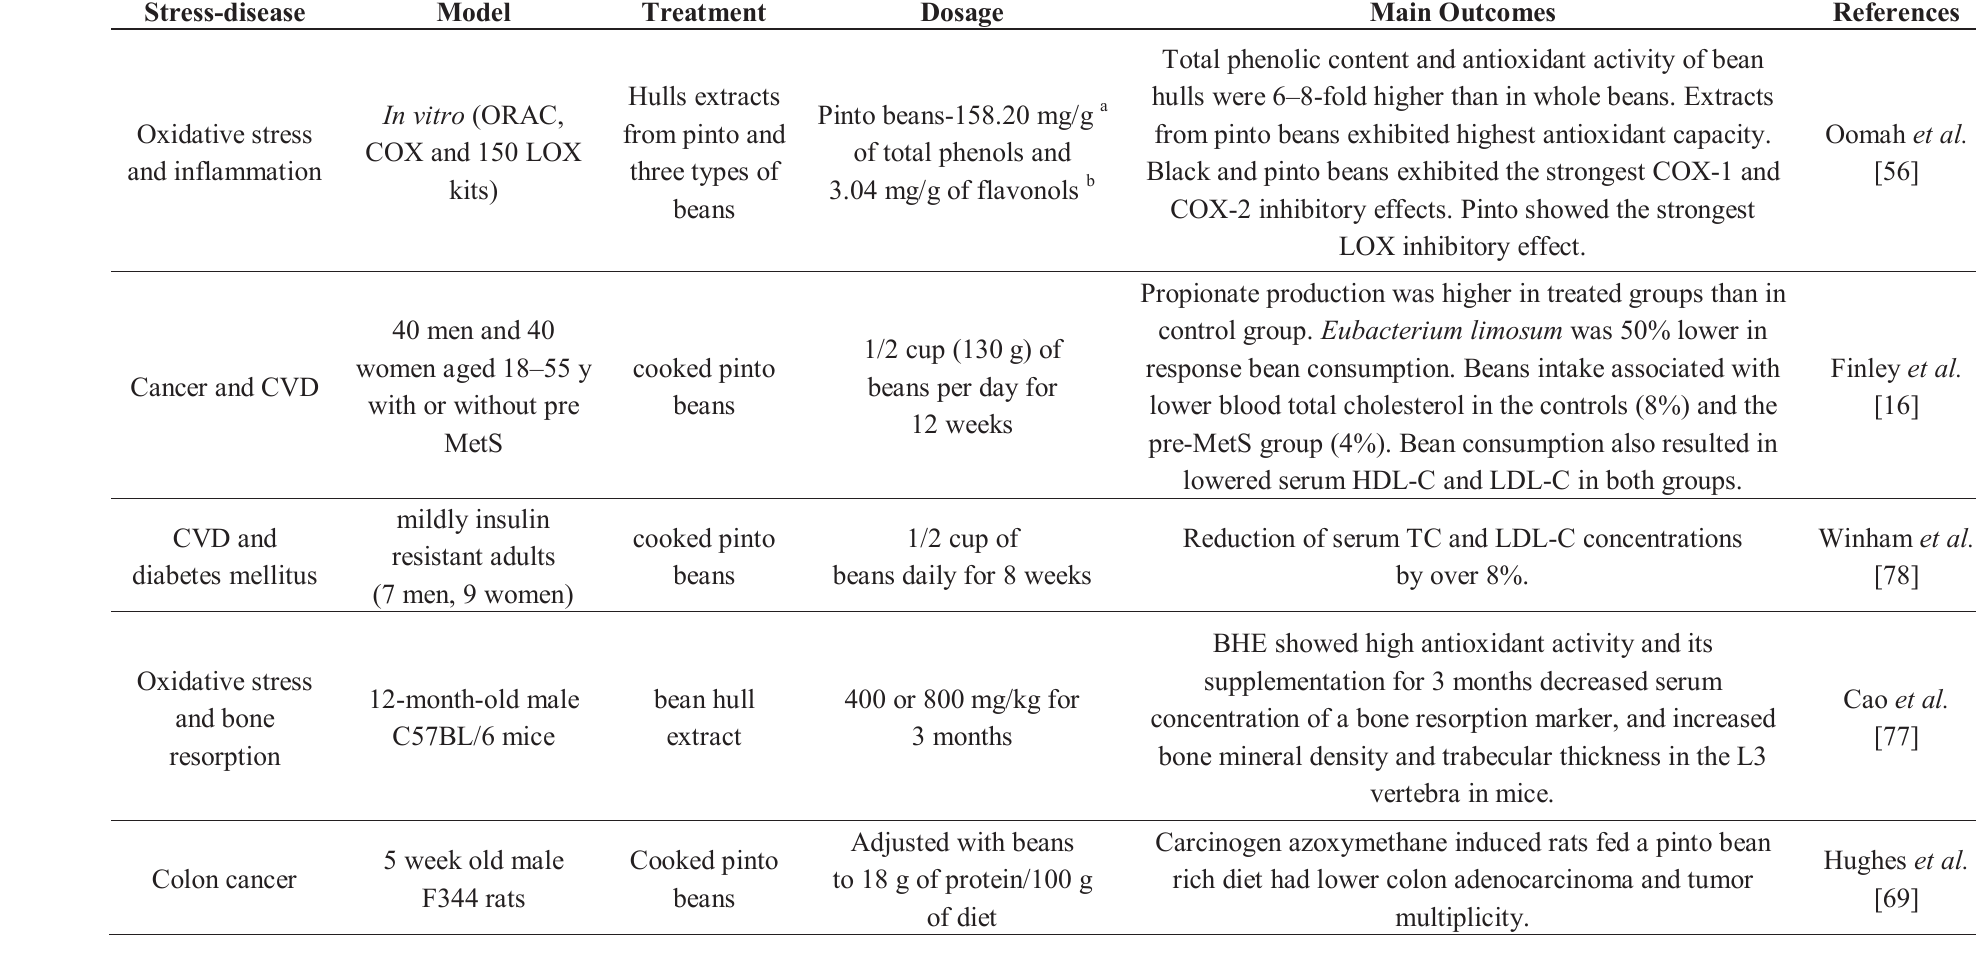
Table 3. Summary of studies on pinto beans and health